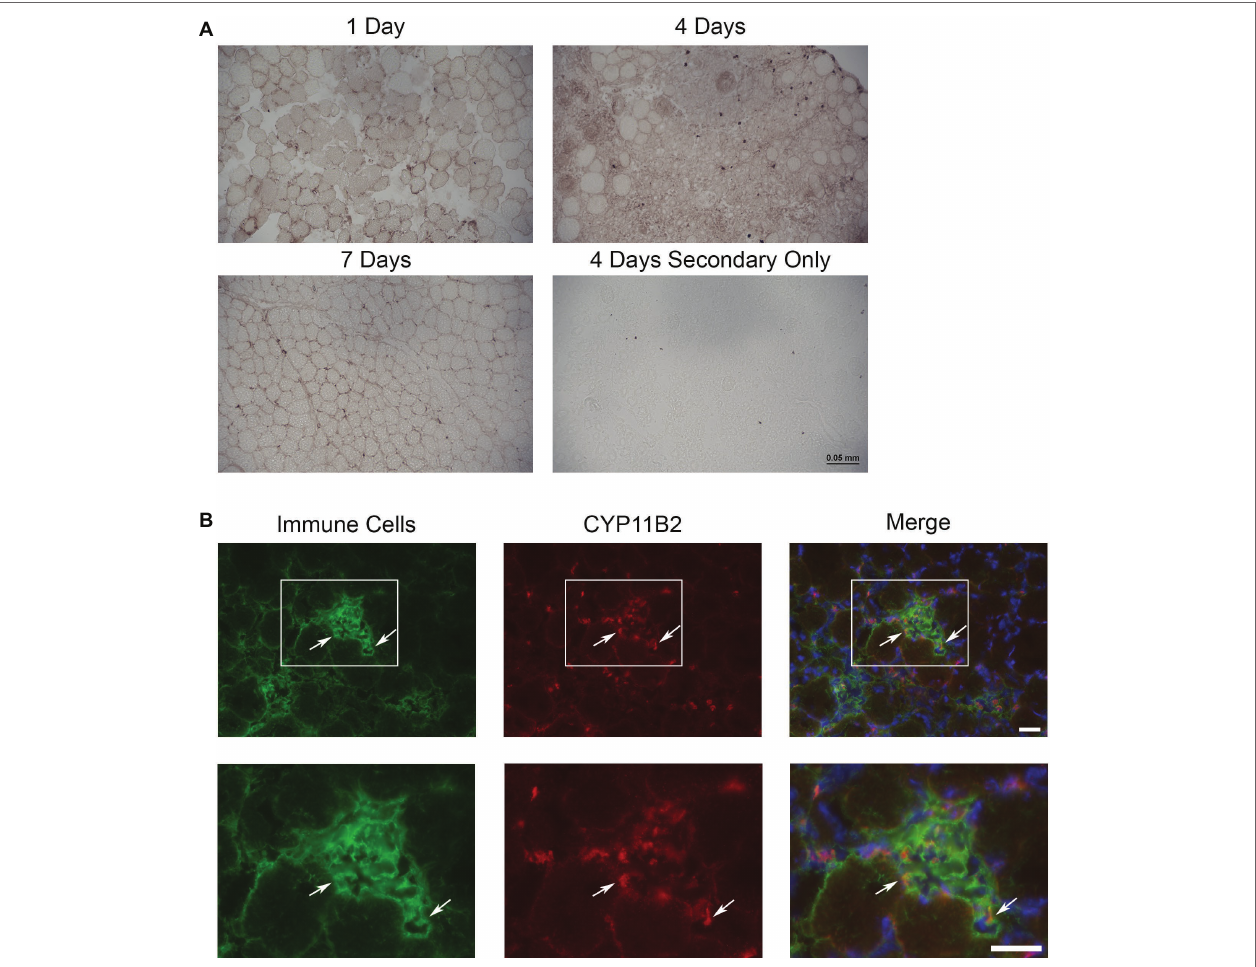
FIGURE 1 | CYP11B2 is present in acutely injured skeletal muscle. (A) The presence of CYP11B2 aldosterone synthase at 1, 4, and 7 days after acute muscle injury in tibialis anterior of wild-type mice was evaluated with immunohistochemistry (brown) and appeared to be present at the highest level at 4 days post-injury ( n = 3 Cre − mice per time point). Scale bar = 50 μ m. (B) CYP11B2 (red) co-localized (arrows) with CD11b + immune cells (green) at 4 days post-injury ( n = 4 Cre − ) similar to that observed in chronic muscle injury (Chadwick et al., 2016). DAPI was used to stain nuclei (blue) in the merged image. The co-localization of CYP11B2 and CD11b + immune cells can be better observed in the zoomed images (bottom panels) for each channel from the area represented by the white box in the top panels. Scale bars = 25 μ